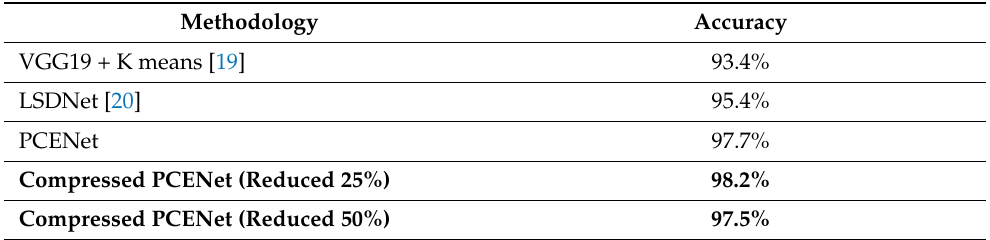
Figure 10. Confusion matrix of the PCENet with 50% filter reduction. Table 6. Proposed methodology comparison with previous work on the corn leaf disease